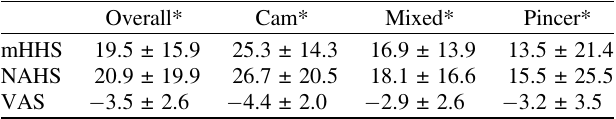
Table 6. The change in PROMs (overall and in each FAI